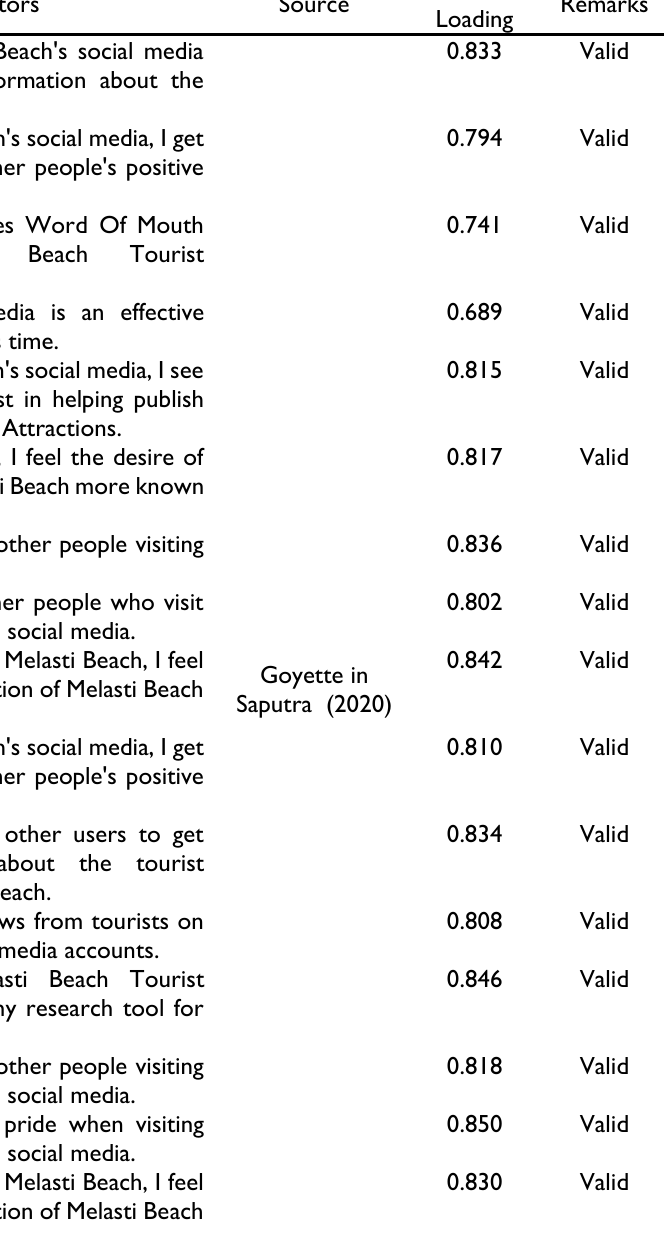
Table 2. Operational Definition Variable and Convergent Validity Test Results